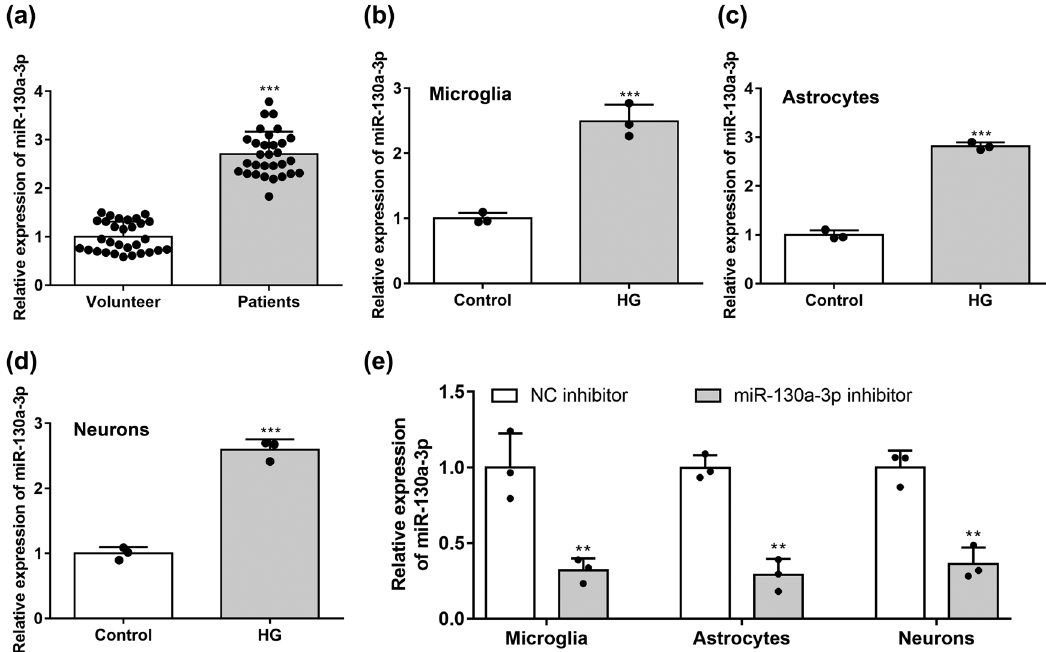
Figure 1: Expression of miR - 130a - 3p in DPN patients and HG - stimulated microglia, astrocytes, and neurons. ( a ) Expression of miR - 130a - 3p in DPN patients ’ tissues was determined by RT - qPCR. Expression of miR - 130a - 3p in HG - stimulated microglia ( b ) , astrocytes ( c ) , and neurons ( d ) compared to that in basal cells was evaluated by RT - qPCR. ( e ) Expression of miR - 130a - 3p in HG - stimulated microglia, astrocytes, and neurons by RT - qPCR. *** P < 0.001 vs